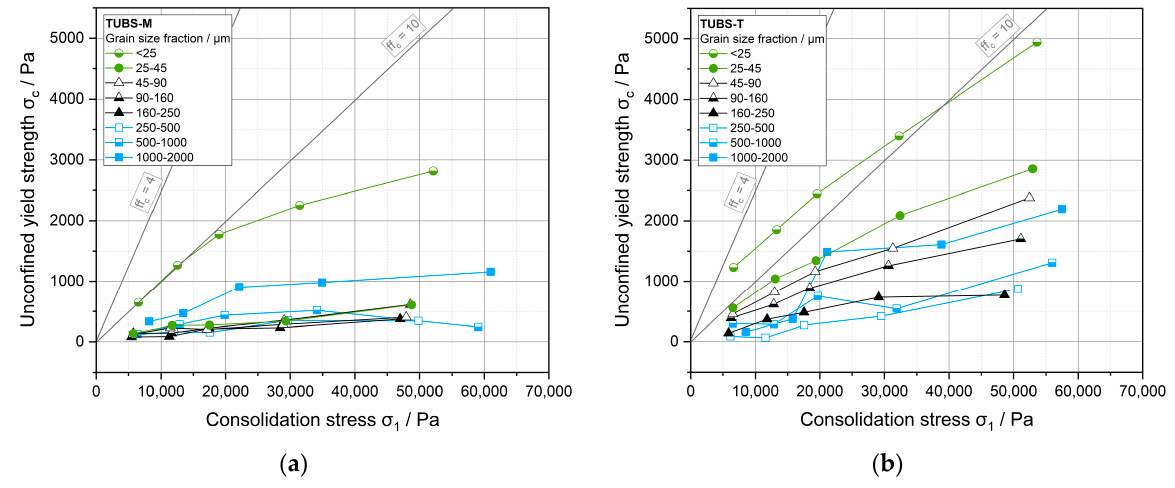
Figure 9. Flow functions of the grain size fractions of TUBS-M ( a ) and TUBS-T ( b ) at shear stresses of 3, 6, 9, 15, and 25 kPa.